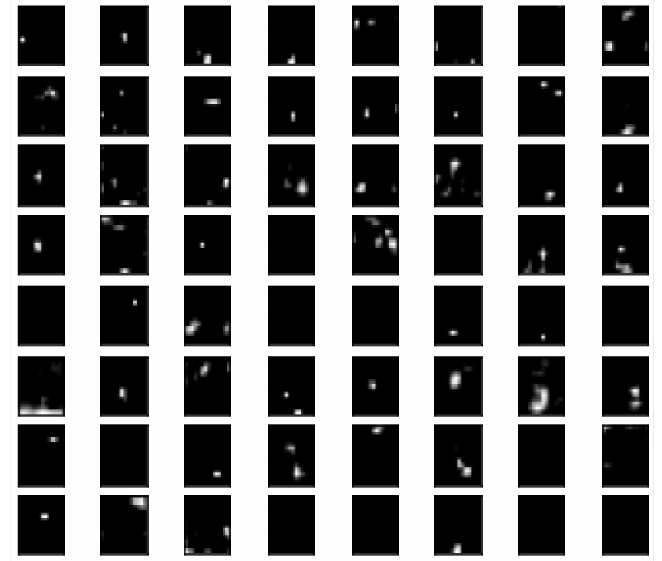
Figure 11. Feature map from Block 5 of the VGG-19